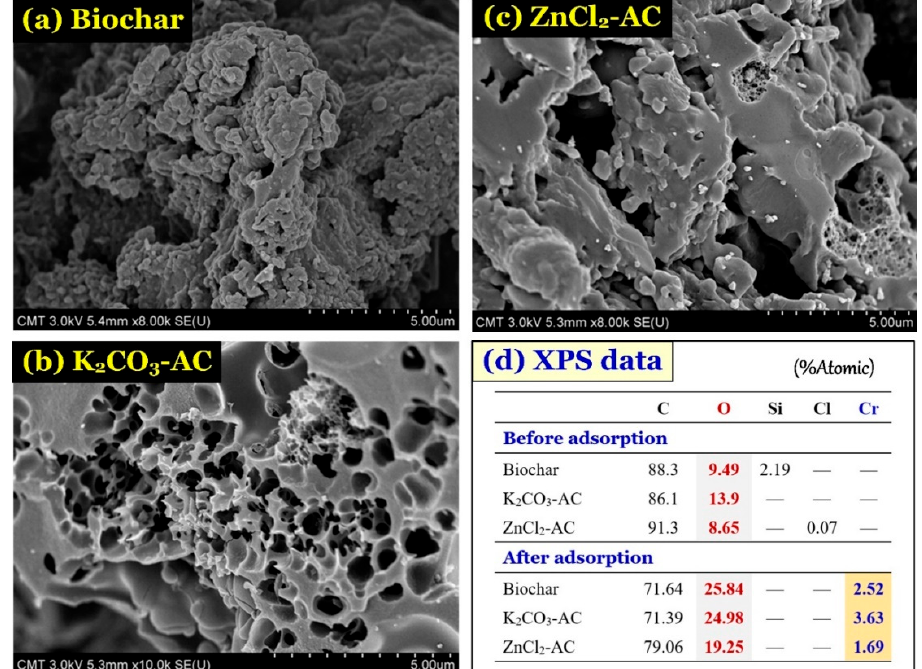
Figure 2. ( a )–( c ) Scanning electron microscope (SEM) image of biochar and activated carbons; and ( d ) their surface element component.